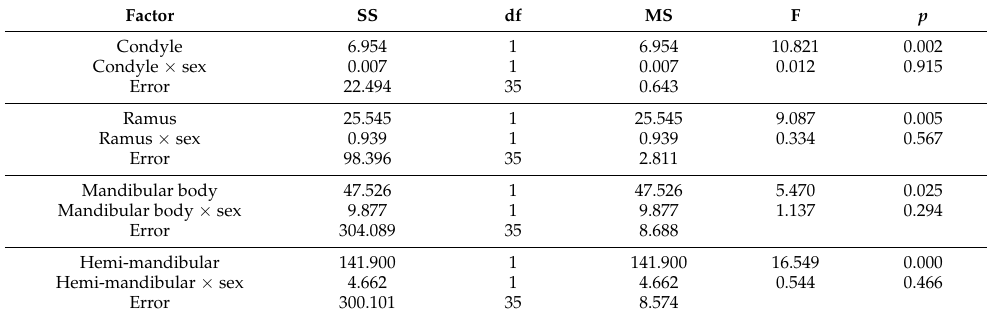
Table 6. Repeated-measures analysis of variance for adjustment of sex for volume measurements.